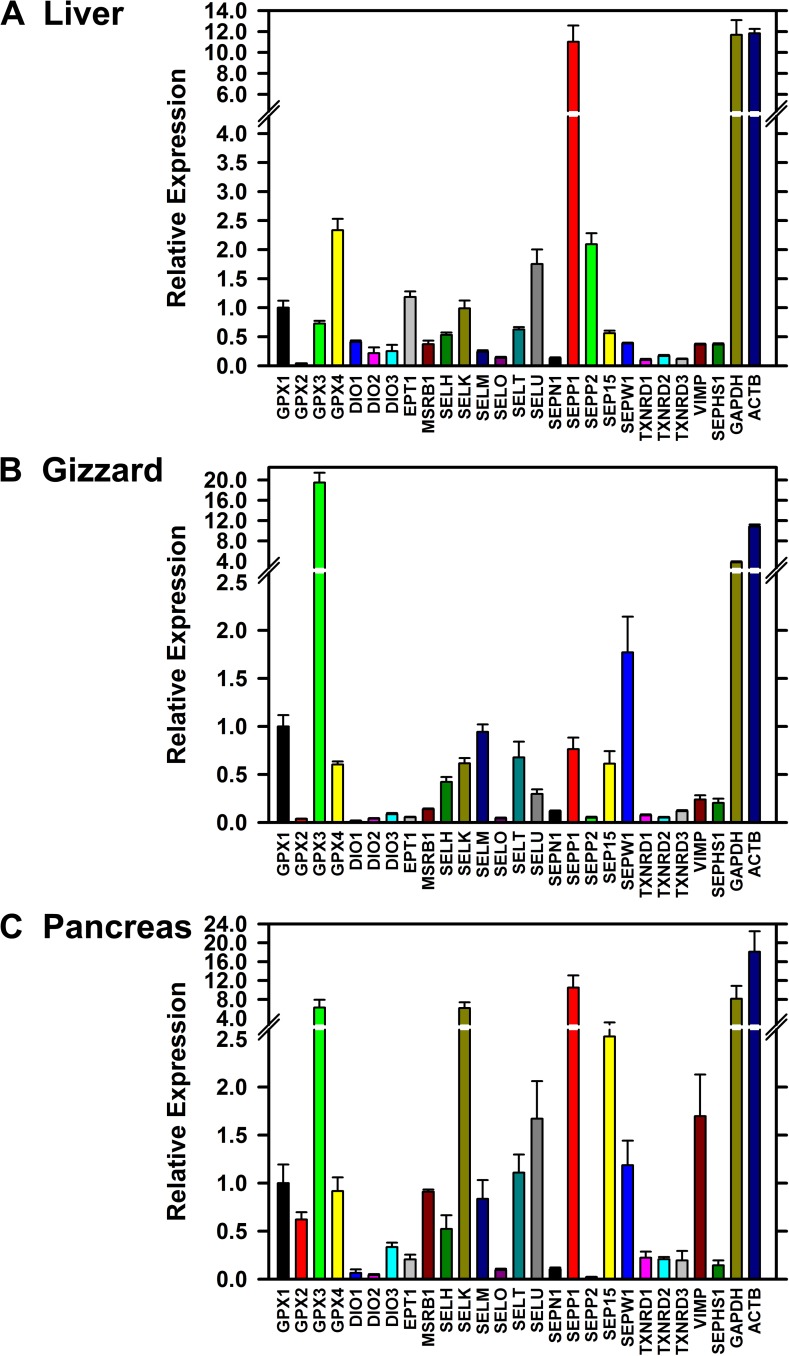
Relative expression of selenoprotein transcripts in Se-adequate chick liver (A), gizzard (B) and pancreas (C). Relative transcript expression for each gene was determined by qPCR and expressed relative to the level of GPX1 transcript, as described in the text. Se-adequate tissues were from chicks fed 0.3 mg Se/g diet. Primer pairs used for these analyses are listed in Table 2. Bars show the mean±SEM (n = 4).